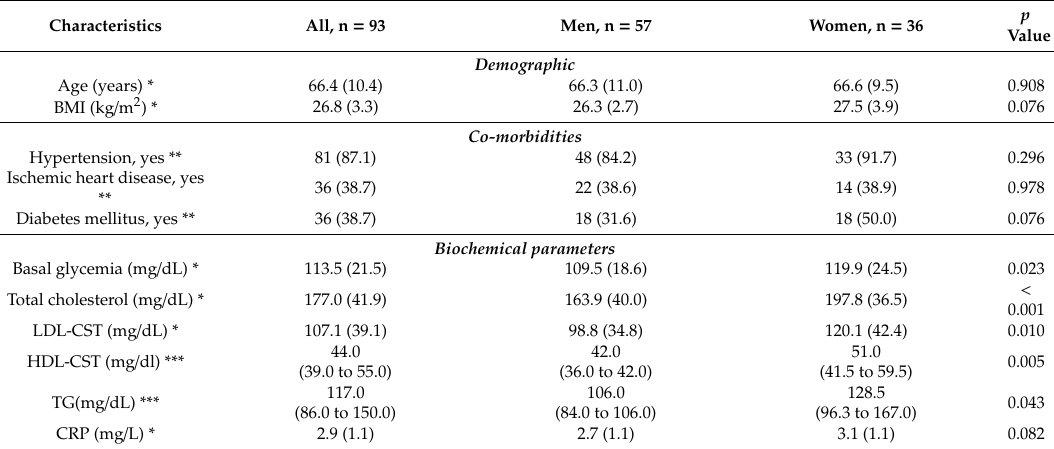
Table 1. Sample baseline characteristics, grouped by